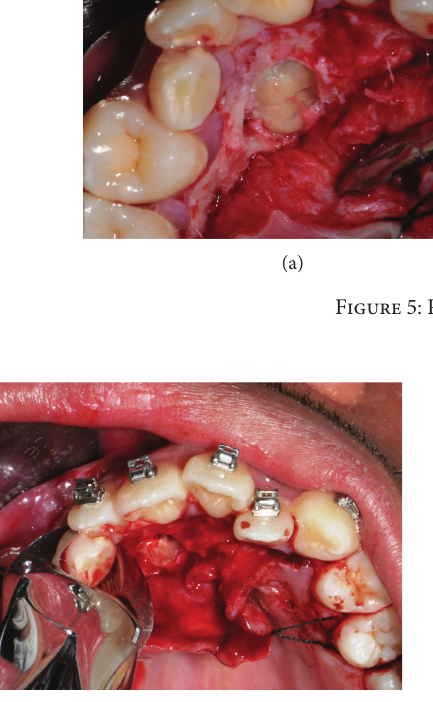
Figure 6: Deciduous canine extraction.